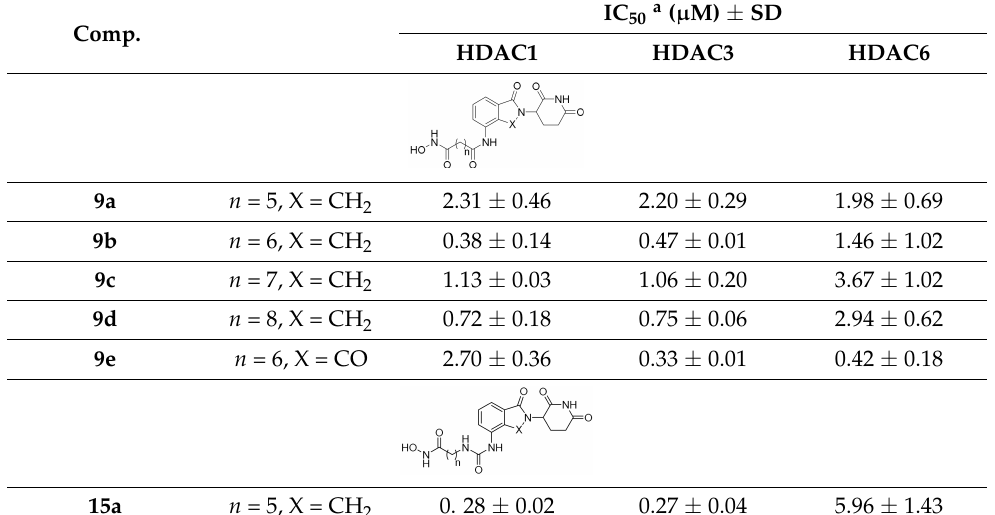
Table 1. In vitro inhibition of molecules against HDAC1, HDAC3, and HDAC6. Comp.